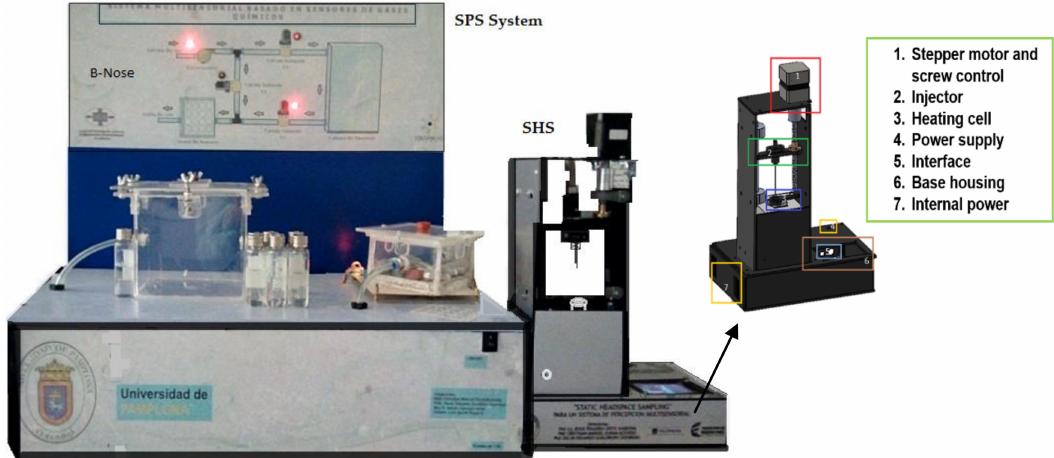
Figure 2. SHS system coupled to SPS